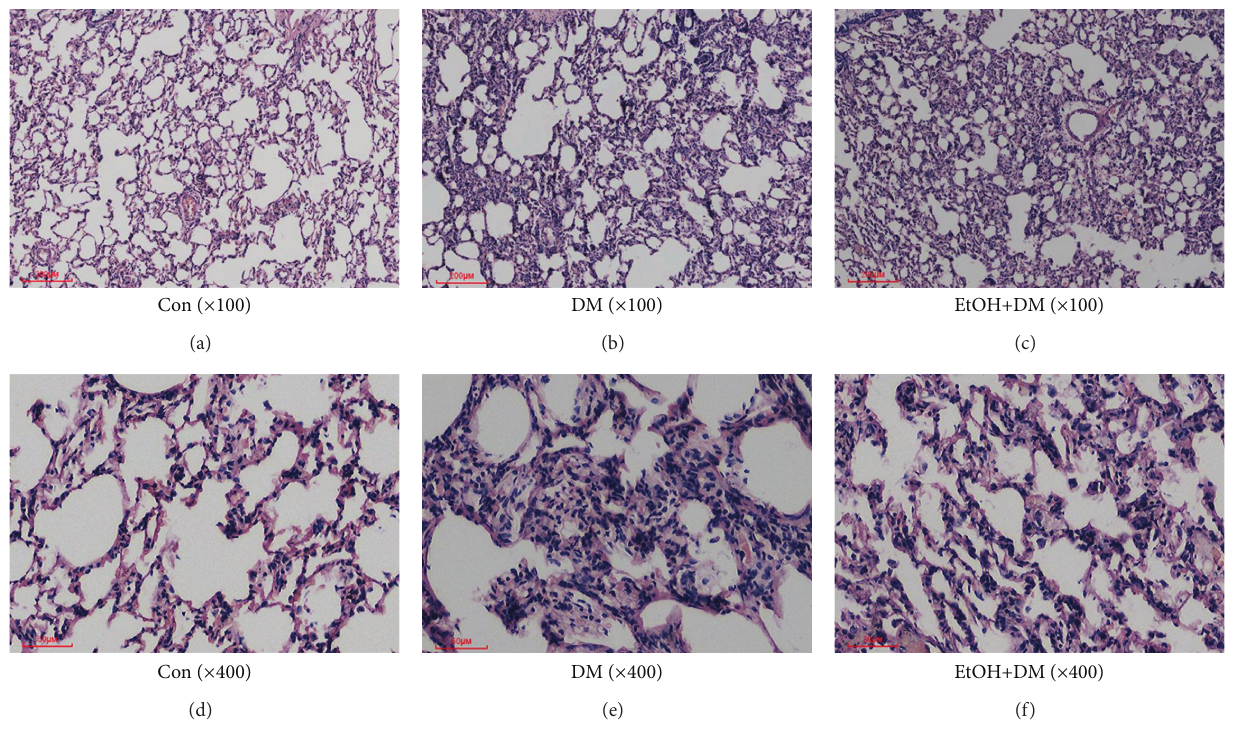
Figure 2: Histological observation of lung tissue in different groups.